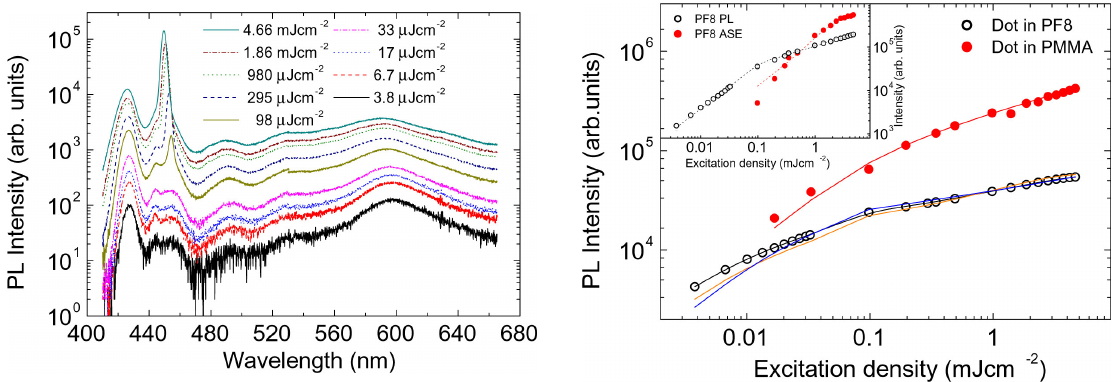
Figure 4. ( left ) Excitation density dependence of the PL spectra of the PF8-NC thin film. ( right ) Integrated PL intensity of the NC emission as a function of the excitation density for the PF8-NC film (empty black dots) and the PMMA-NC one (full red dots). Inset: integrated intensity of the PF8 PL (empty black dots) and amplified spontaneous emission (ASE) (full red dots) in the PF8-NC film as a function of the excitation density. All the lines are the best fit curves. Reprinted with permission from [41]. American Chemical Society,